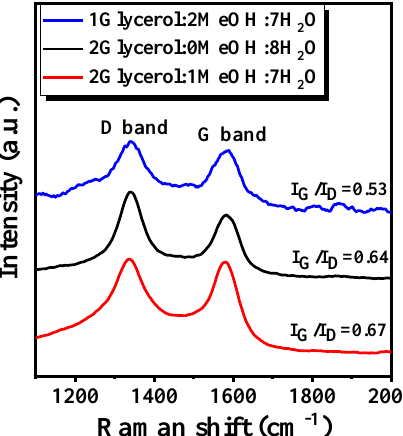
Figure 10. Raman spectrum of the Ni/Ti-600R catalyst for different mixed-alcohol feed after 20 h stability test.